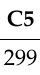
Table 3. The collapse voltages of C3–C5.